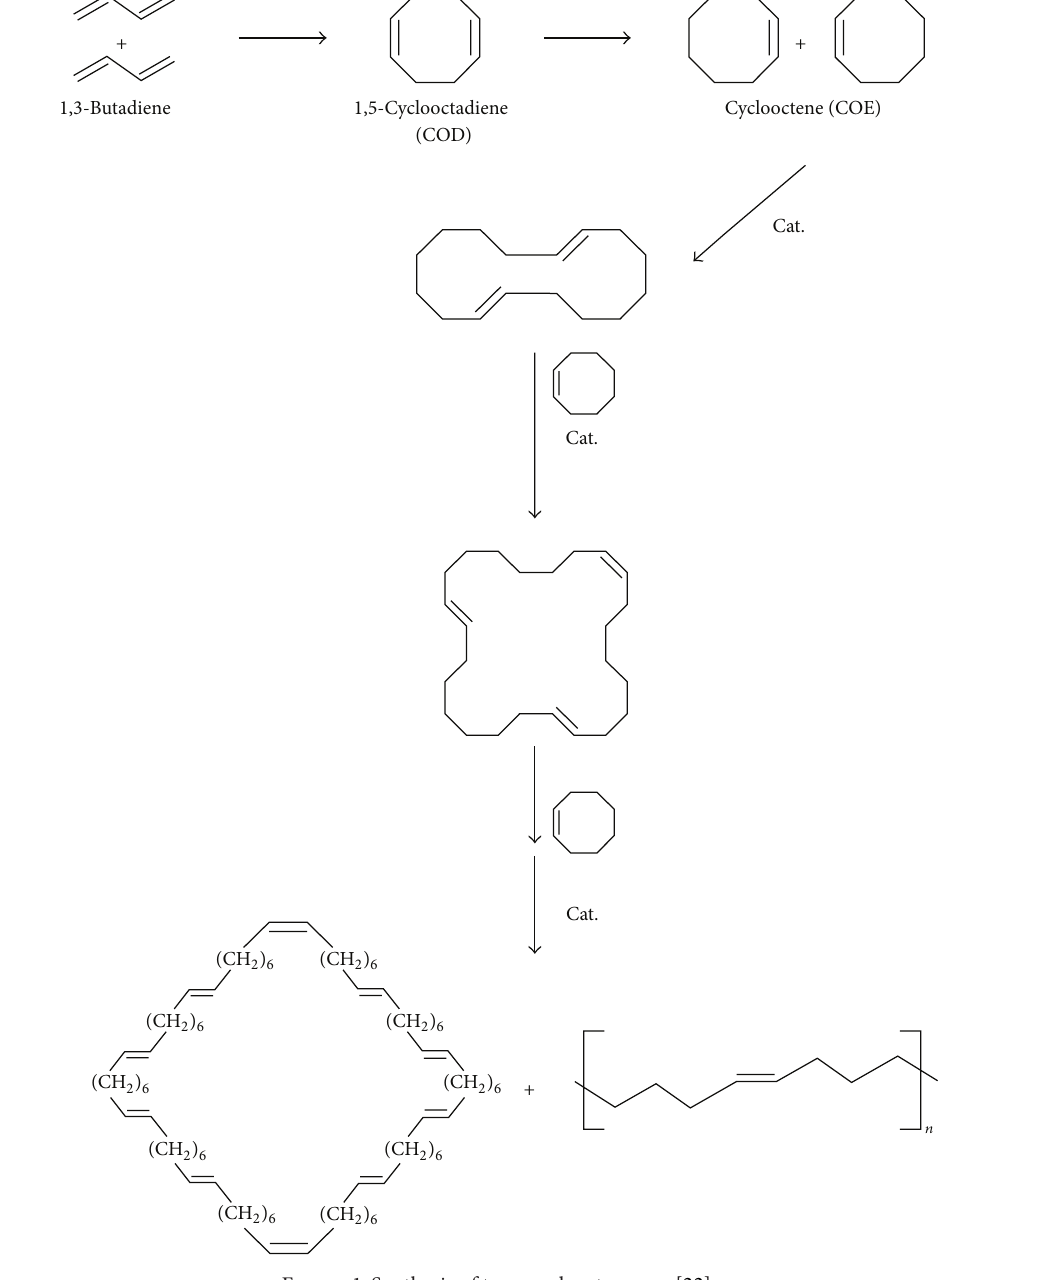
Figure 1: Synthesis of trans-polyoctenamer